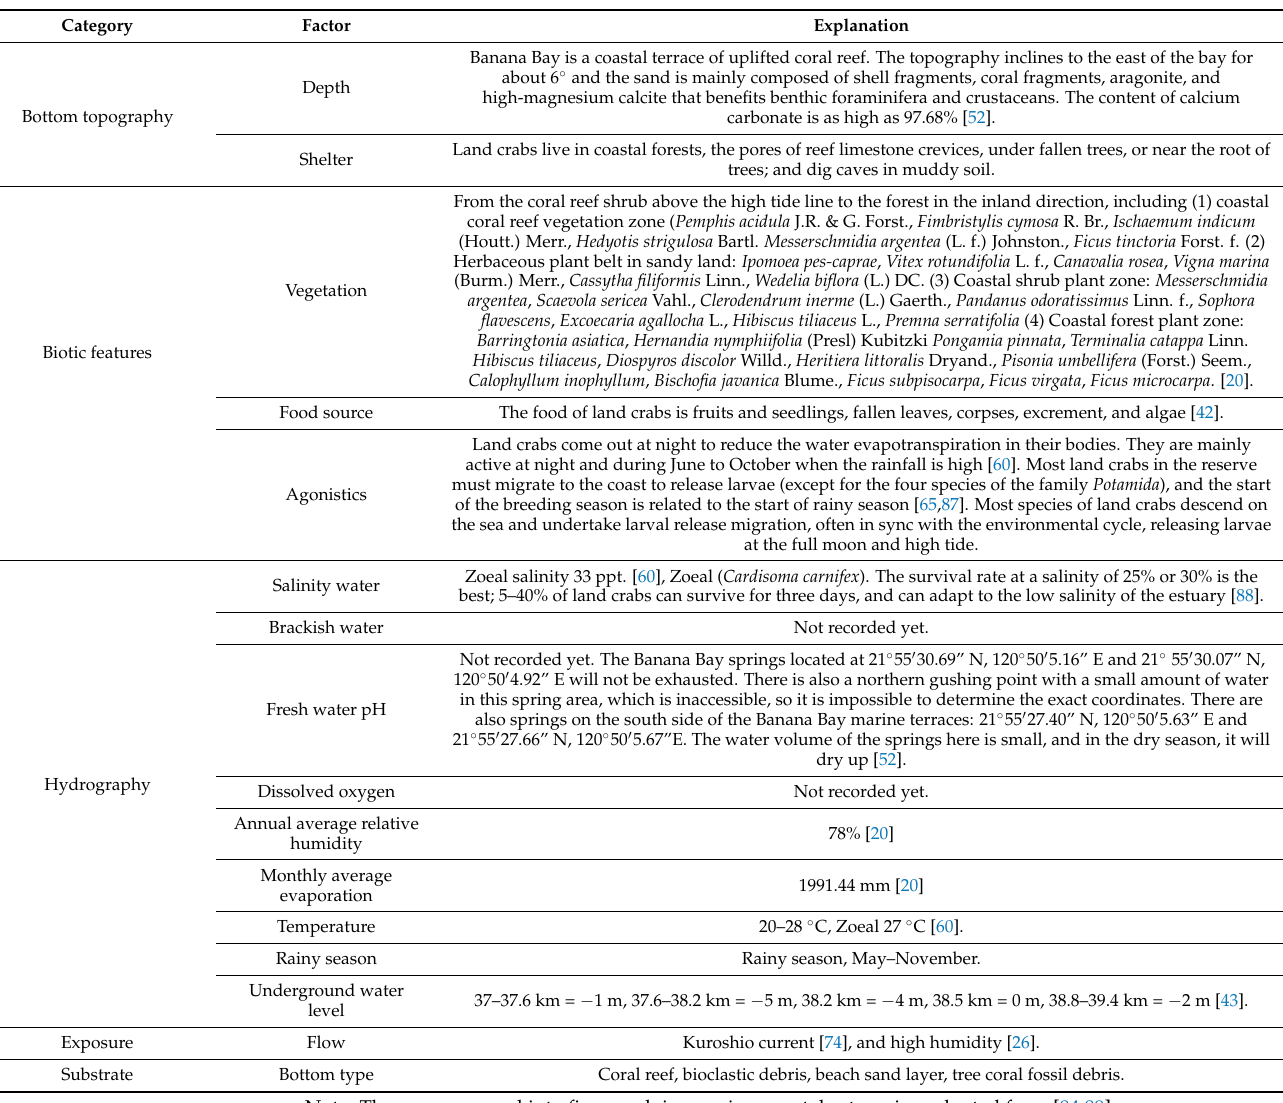
Table 4. Environmental factors that affect the microhabitat of Banana Bay land crabs in the re- viewed